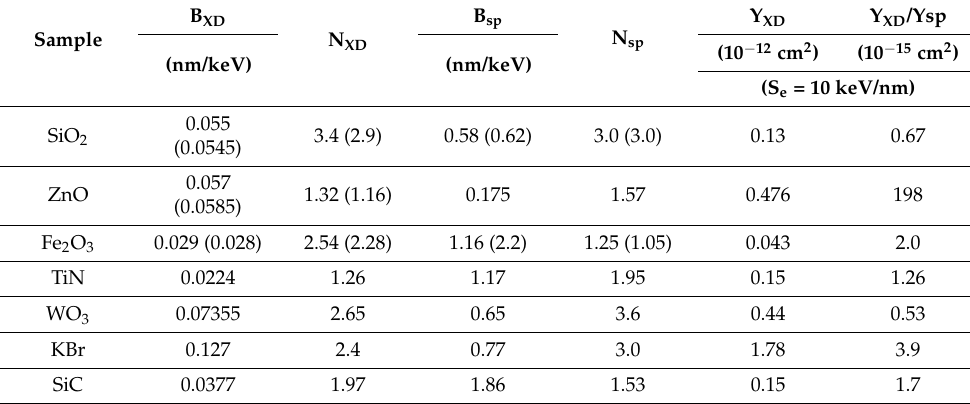
Table 6. Summary of electronic stopping power (S e in keV/nm) dependence of lattice disordering Y XD = (B XD S e ) NXD for the present results of SiO 2 , ZnO, Fe 2 O 3 and TiN films, and sputtering yields Y sp = (B sp S e ) Nsp of the present result for TiN. Lattice disordering and sputtering yields of WO 3 film from [58,72], those of KBr and SiC from [56] and sputtering yields of SiO 2 , ZnO and Fe 2 O 3 (see Section 3). Constant B XD and B sp and the exponent N XD and N sp are obtained using TRIM1997 and those using SRIM2013 are in parentheses. Y XD at S e = 10 keV and Y XD /Y sp (10 − 15 cm 2 ) are